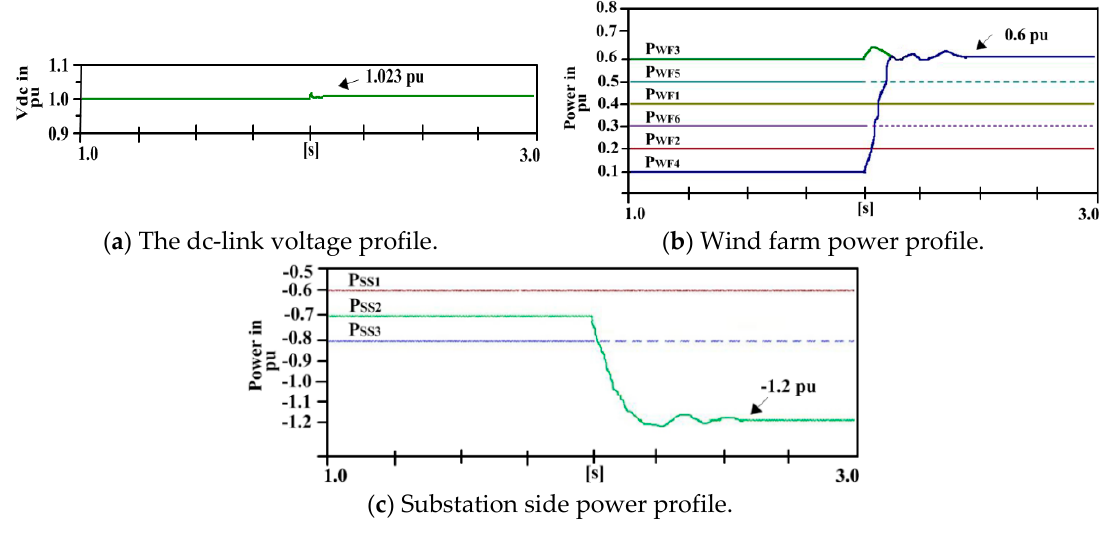
Figure 12. Line–line dc fault on cable L 56 .